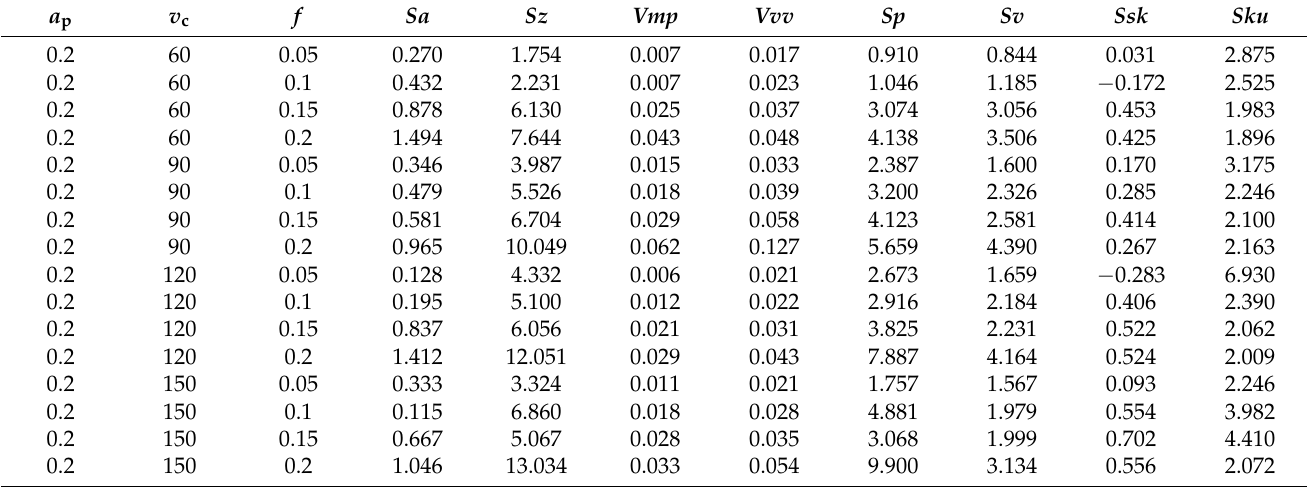
Table A3. Topography parameter data (hard turning, a p = 0.2 mm).